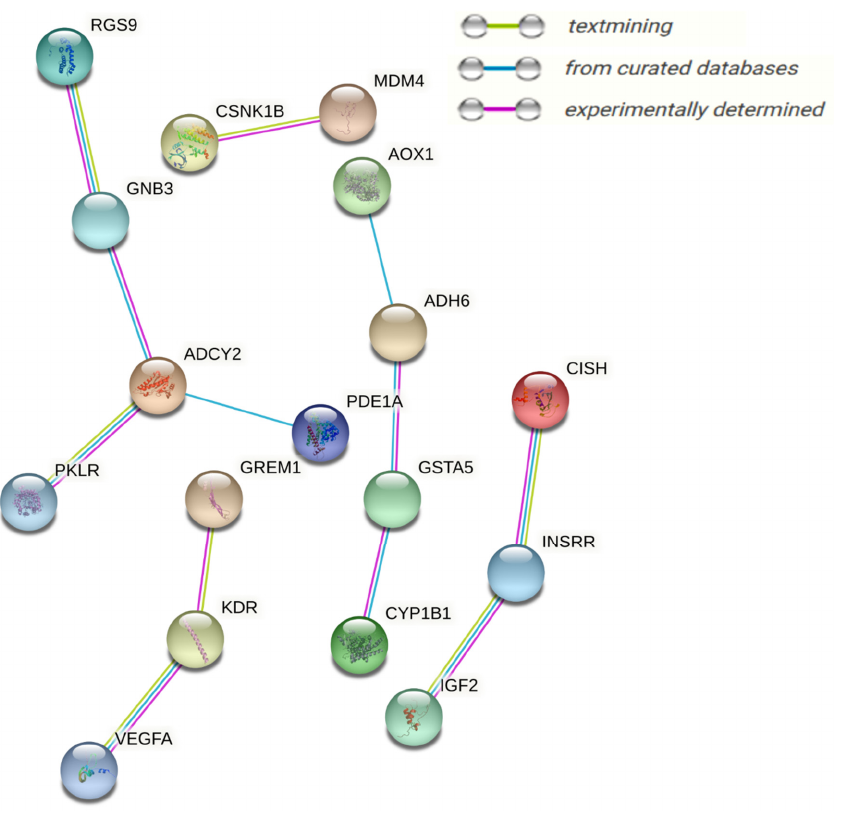
Figure 10. Differentially expressed genes found in multiple integrations and the network analysis of the transcriptome and metabolome response of granulosa cells to acute heat stress are drawn into a physical protein–protein interaction network (STRING); medium confidence score (0.4) nodes represent proteins and lines between nodes, referring to edges showing various sorts of interactions, denoted by different colors and defined through the figure legends.